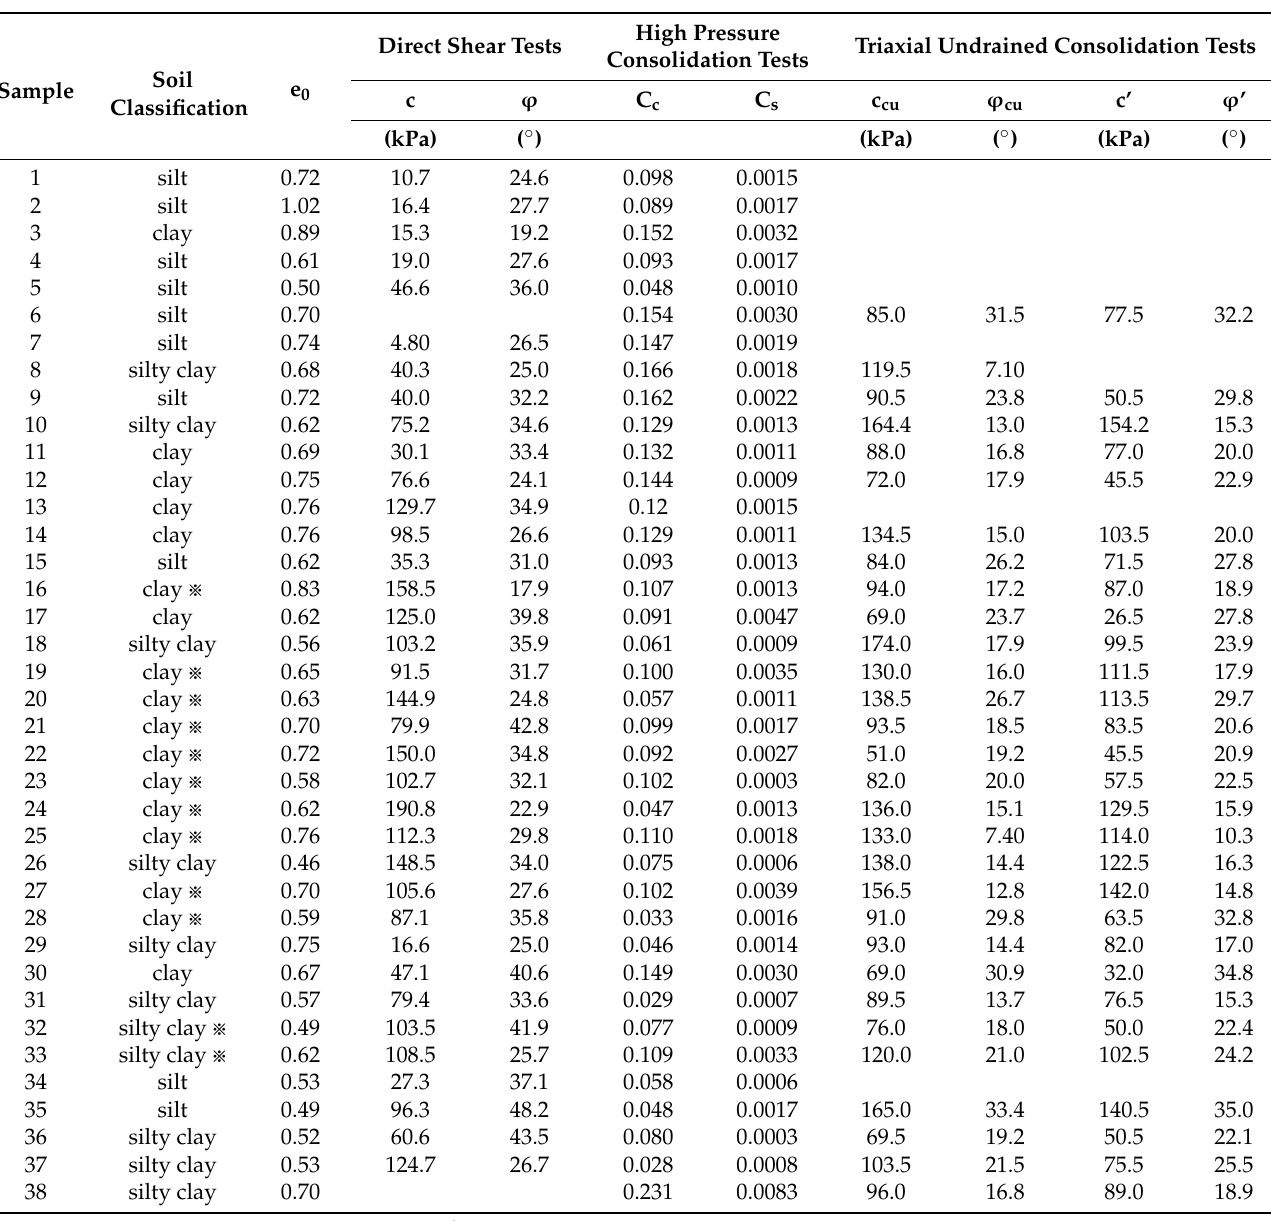
Table 3. Table of soil mechanical strength